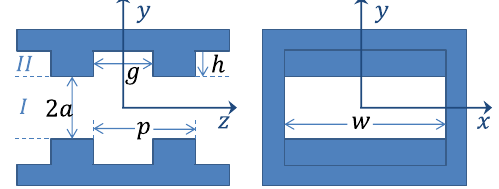
FIG. 1. Geometry of dechirper parameters: longitudinal cut with two periods (left) and transverse cut (right).